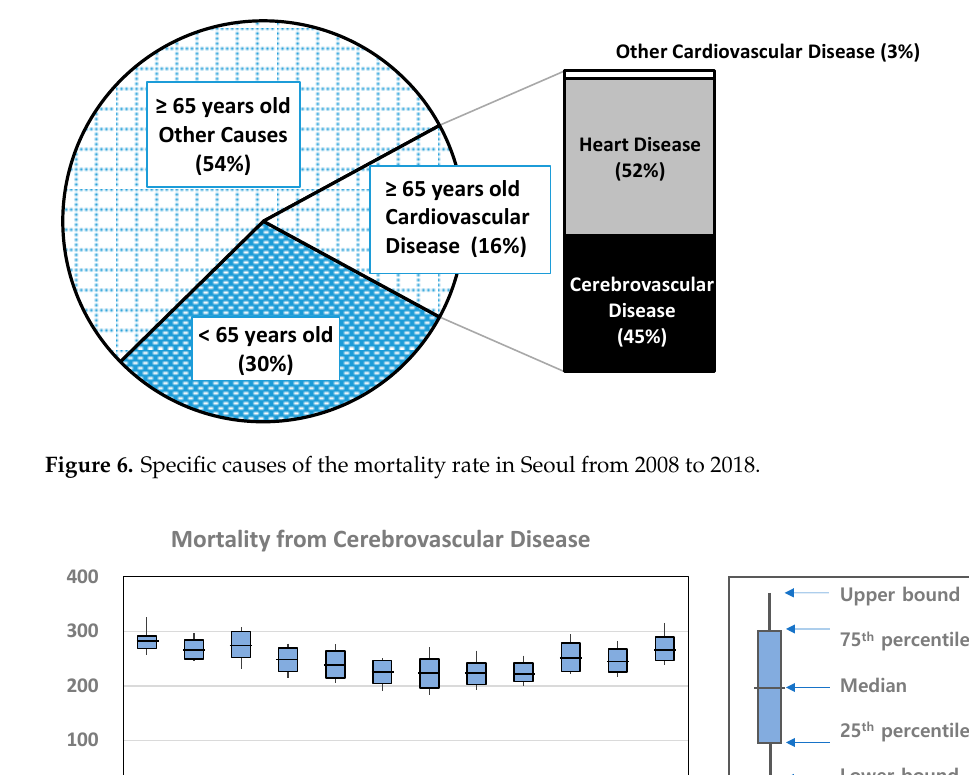
Figure 8. Comparison of monthly average PM 10 levels on days of high and low probability of death and the differences in PM 10 (PM 10 (high probability of death) –PM 10 (low probability of death) ) from zero to two days before death.